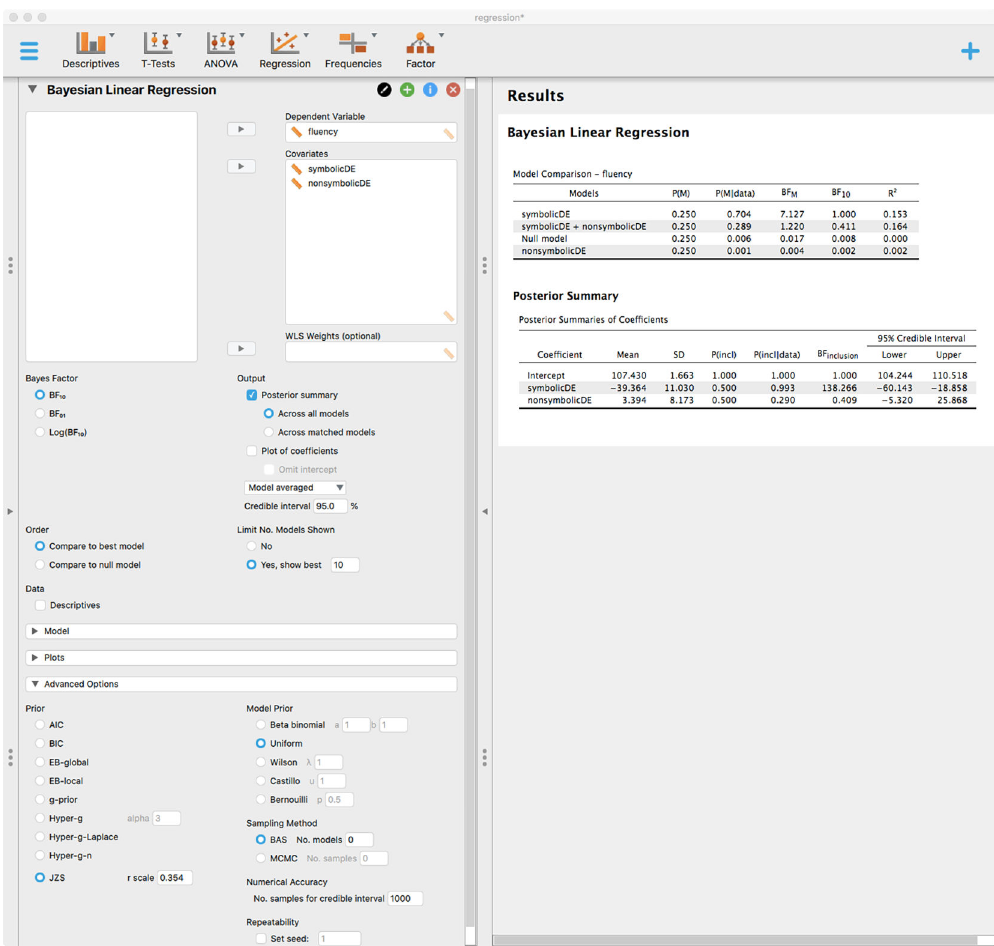
Figure 8. JASP screenshot showing a Bayesian linear